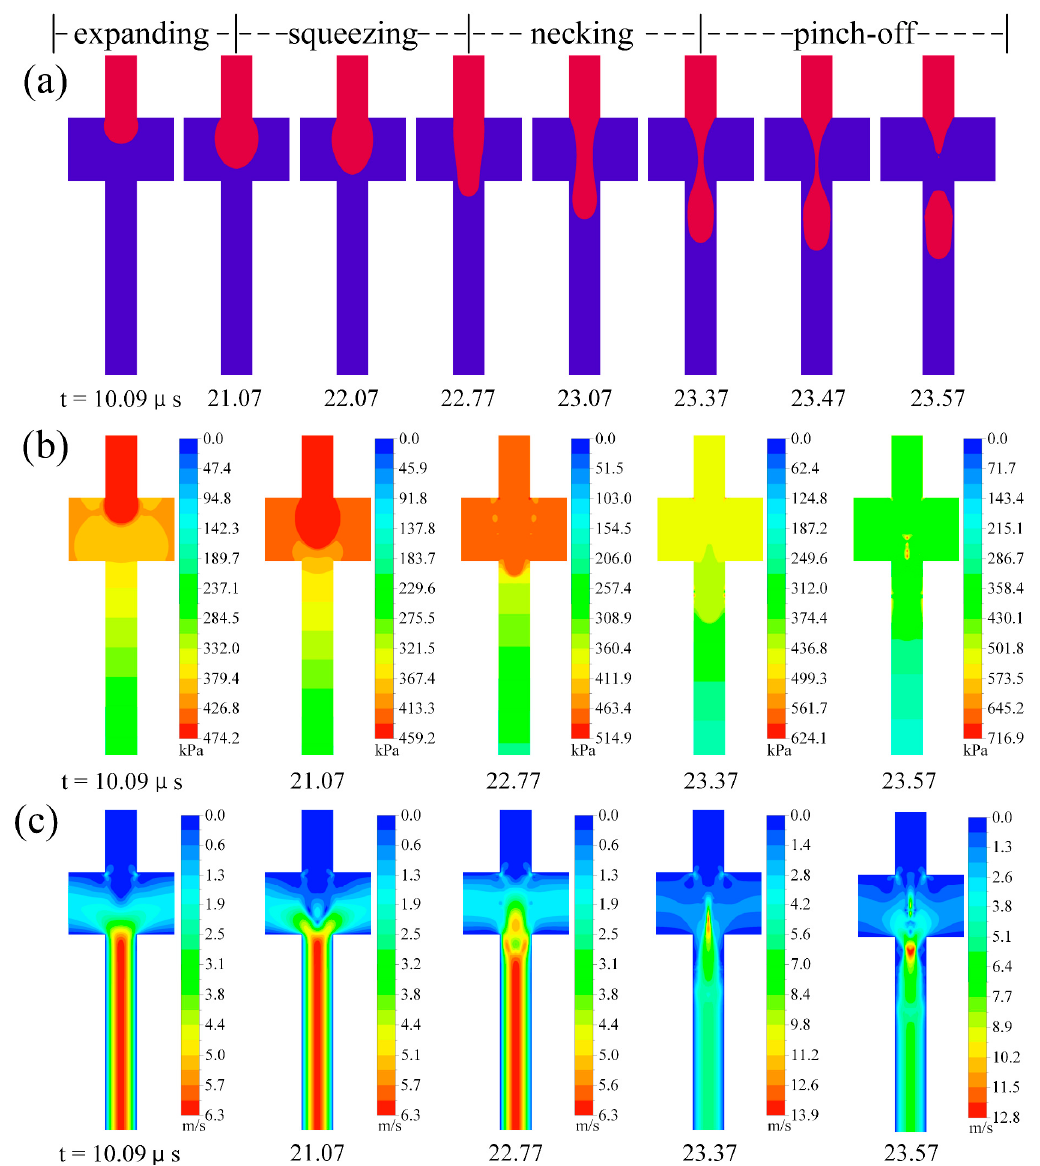
Figure 10. Time evolution of hydrodynamic information during microbubble generation in traditional microchannel (Ca = 0.0139, U d = 0.2 m/s): ( a ) evolution of the interface, ( b ) evolution of pressure field, and ( c ) evolution of velocity field.